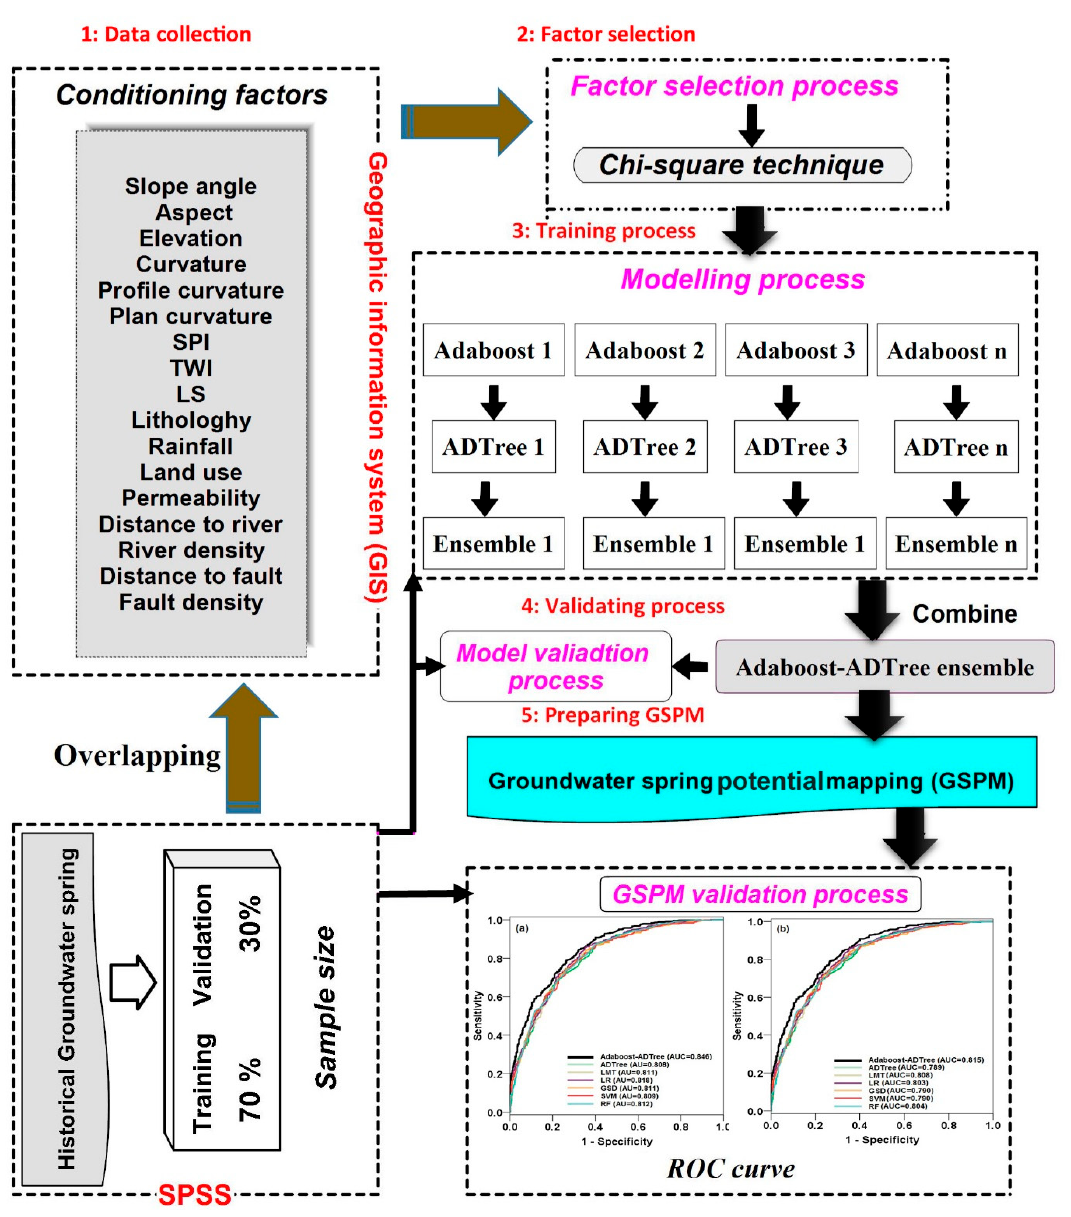
Figure 2. The flowchart of the methodology for groundwater spring potential mapping. Abbreviations: ROC, receiver operating characteristic.